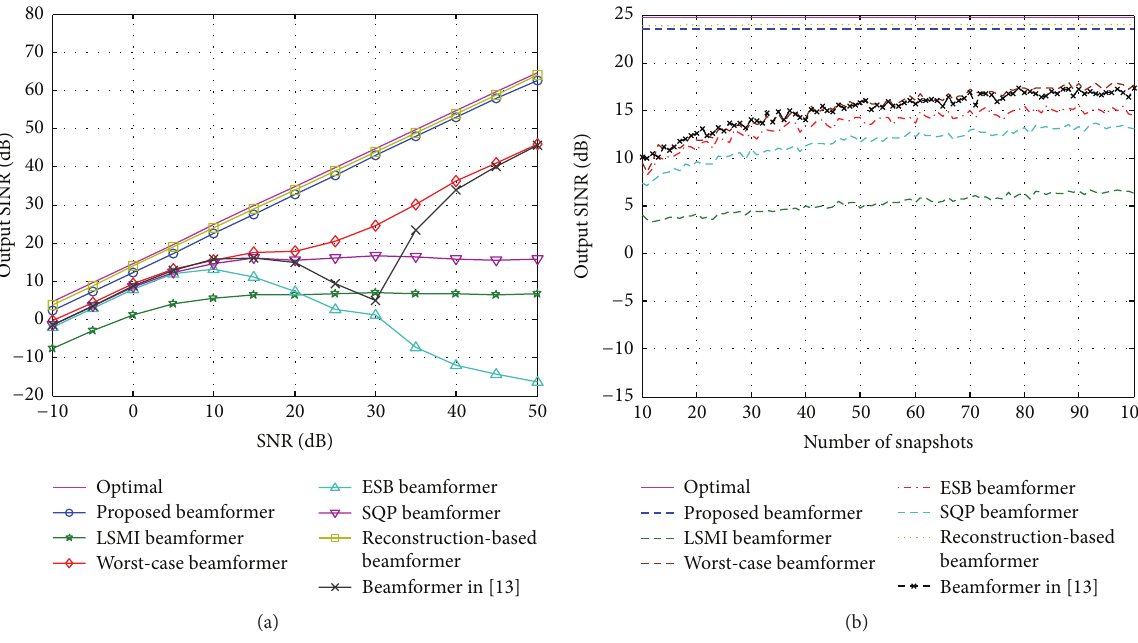
Figure 5: Performance of the beamformers for the case of incoherent local scattering. (a) Output SINR versus SNR for training data size of 𝐾 = 60 and INR = 30 dB. (b) Output SINR versus number of snapshots for fixed SNR = 10 dB and INR = 30 dB.